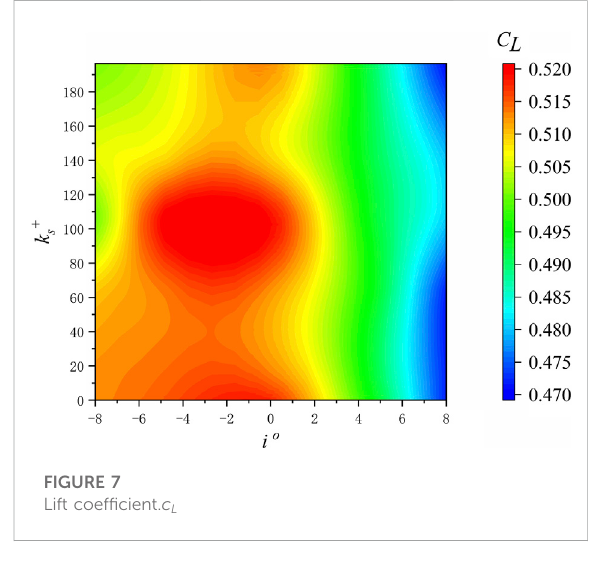
FIGURE 7 Lift coef fi cient. c L